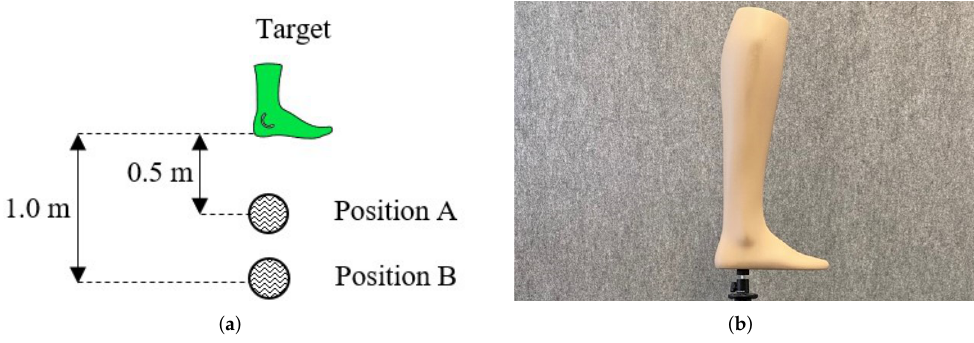
Figure 2. Experimental Setup for the foot reconstruction with the ToF and SL cameras: ( a ) experimen- tal setup for the foot reconstruction; ( b ) foot model used for the reconstruction